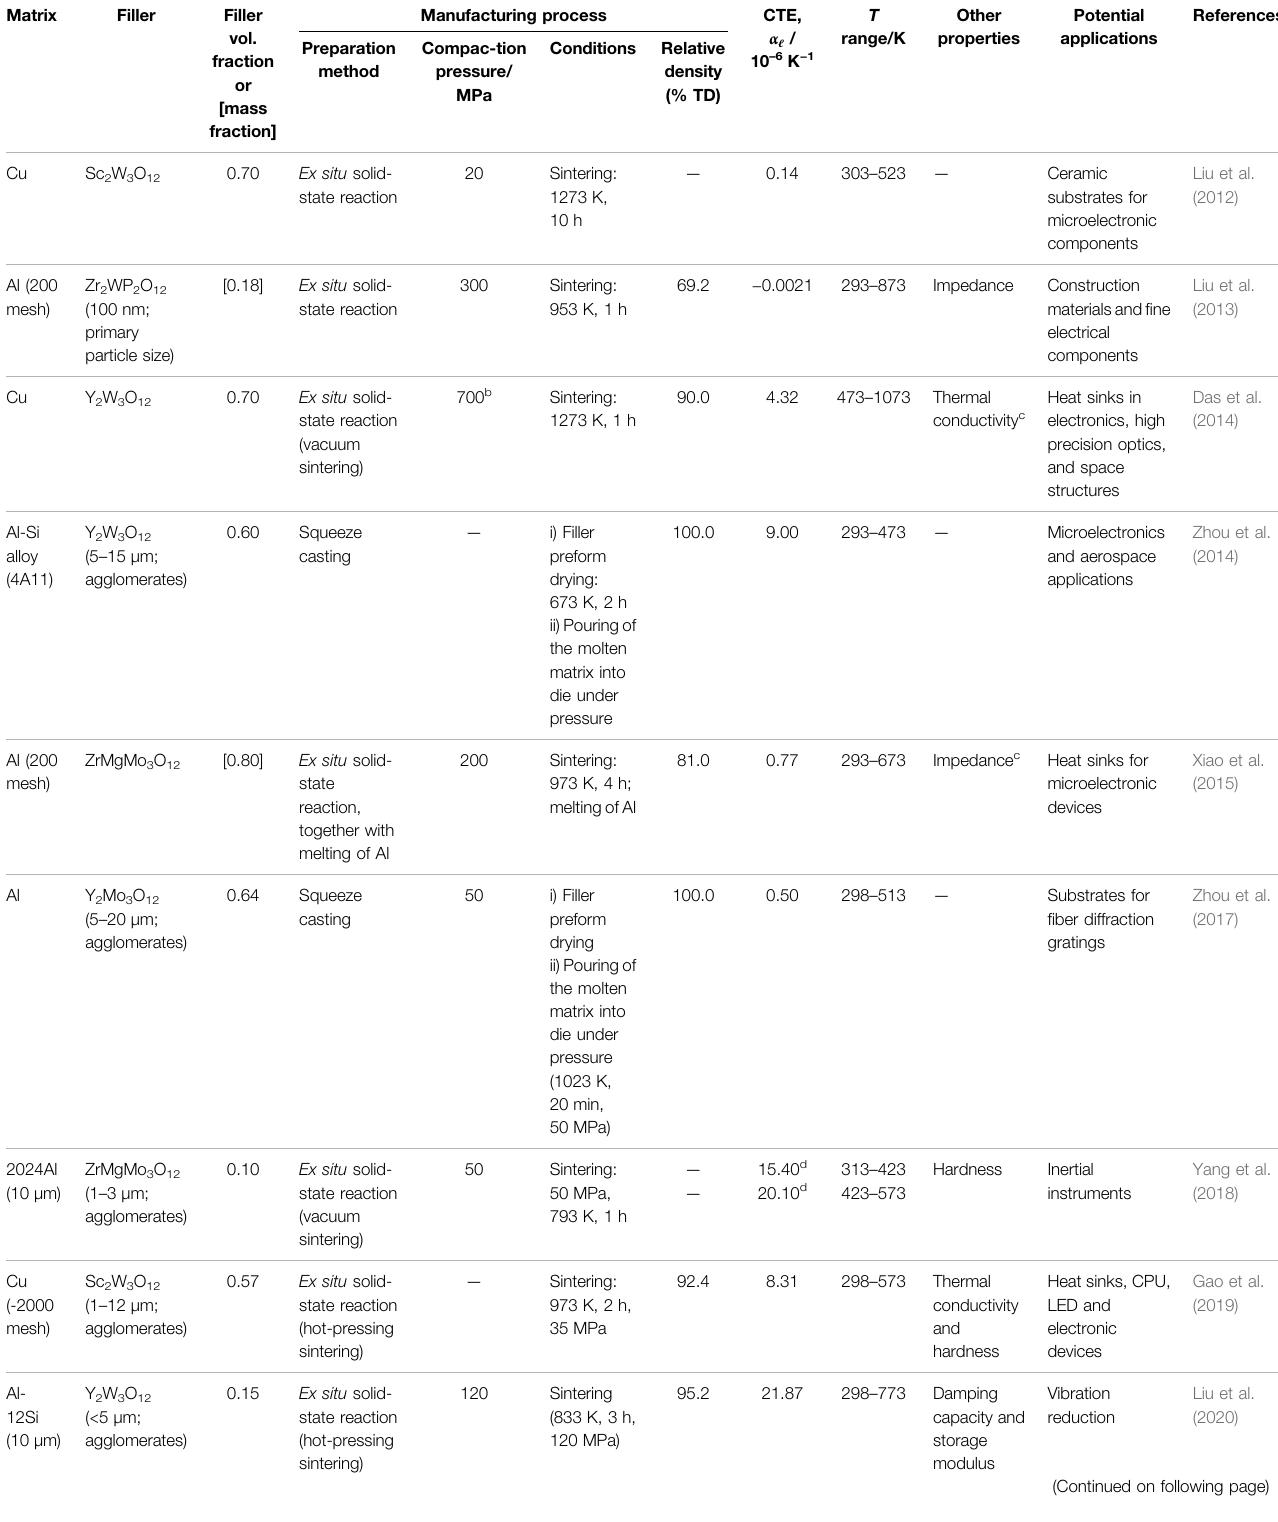
TABLE 2 | Metal matrix composites (MMCs) fi lled with A 2 M 3 O 12 and related materials, their manufacturing process, linear CTE and potential applications a